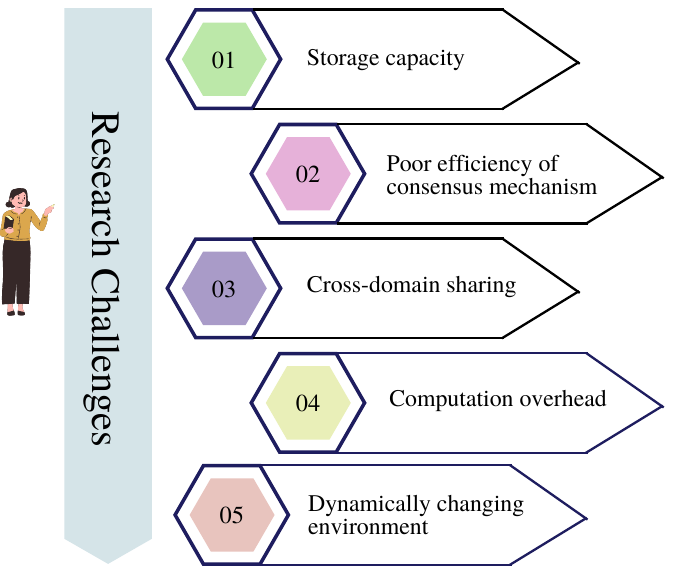
Figure 7. Blockchain adoption challenges in 6G